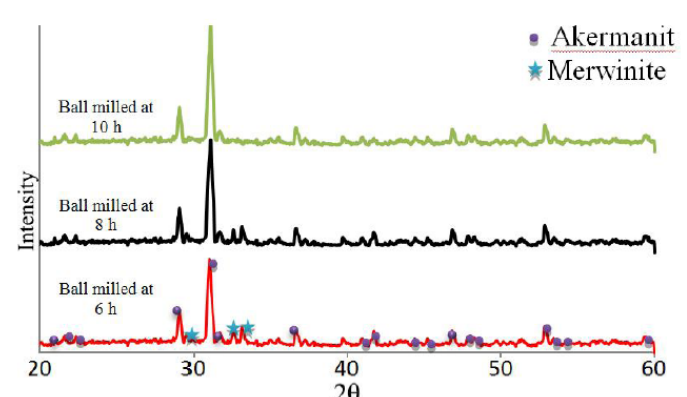
Fig. 1. XRD pattern of akermanite powders milled for 6, 8, and 10h and sintered at 1100°C for 3h